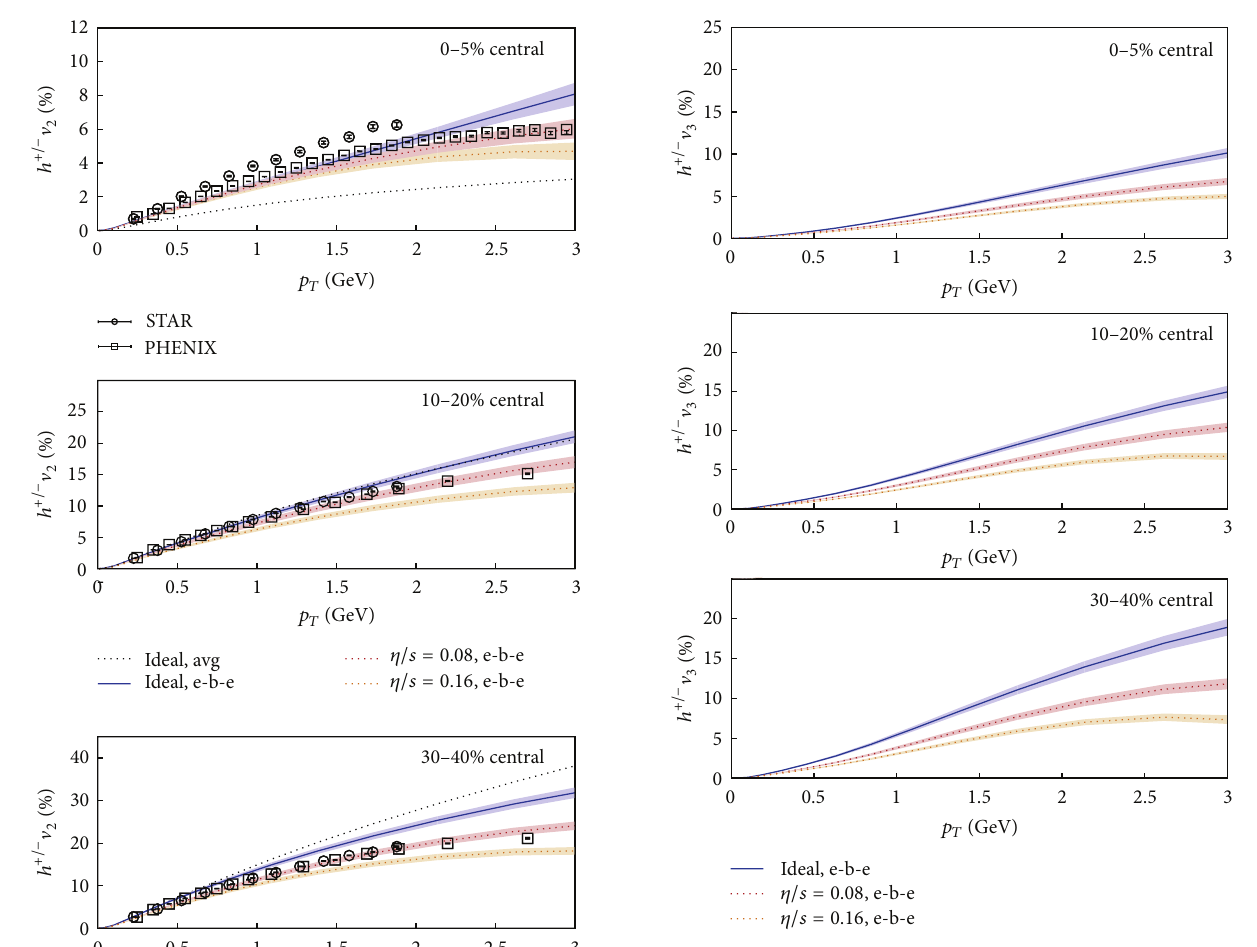
Figure 17: Same as in Figure 16 but for triangular flow. The figures are from